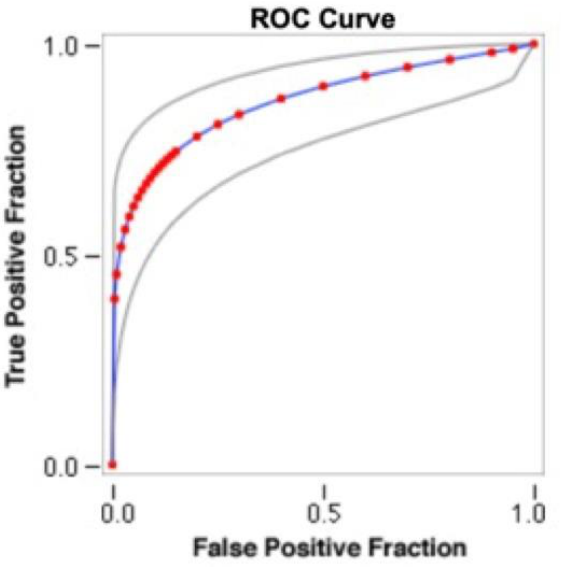
Figure 1. Nonparametric receiver operating curve (ROC) analysis for MBL (mesial + distal/2) at 24 months. The areas under the ROC (AUC) are significant.